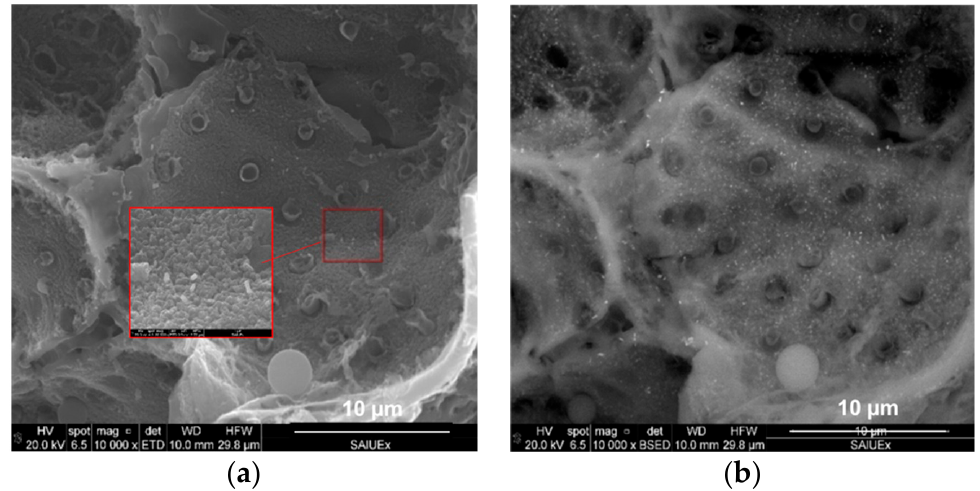
Figure 4. SEMmicrographsincorporating( a )secondaryelectronsand( b Figure 4 . SEM micrographs incorporating ( a ) secondary electrons and ( b ) a detector of retrodispersed electrons .